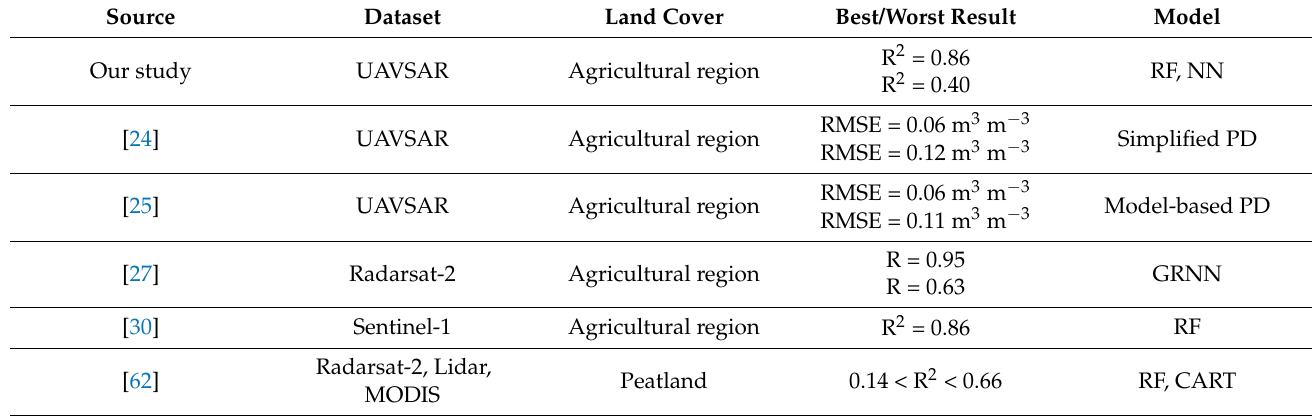
Table 9. A summary of above-mentioned studies for soil moisture retrieval using SAR dataset (PD = polarimetric decomposition).